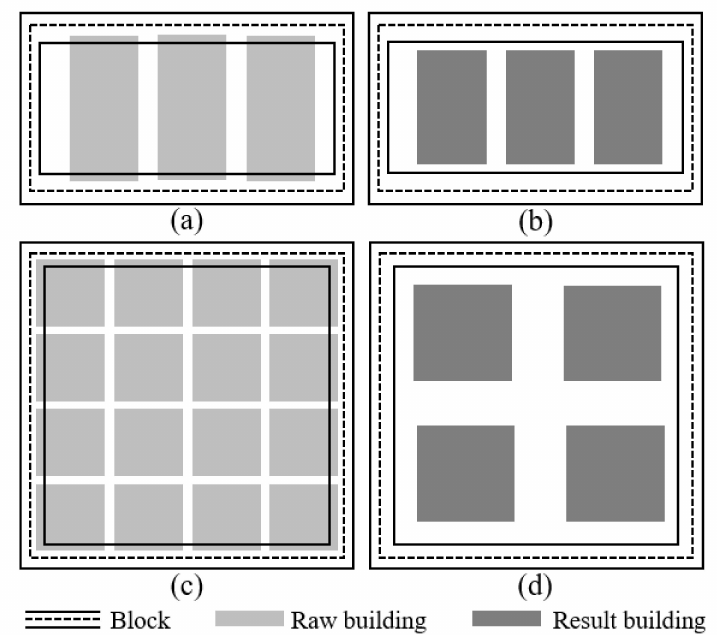
Figure 11. Other generalization operation examples. ( a ) Case of overlap conflict; ( b ) Result using the size reduction operation; ( c ) Case of overlap conflict; ( d ) Result using the typification